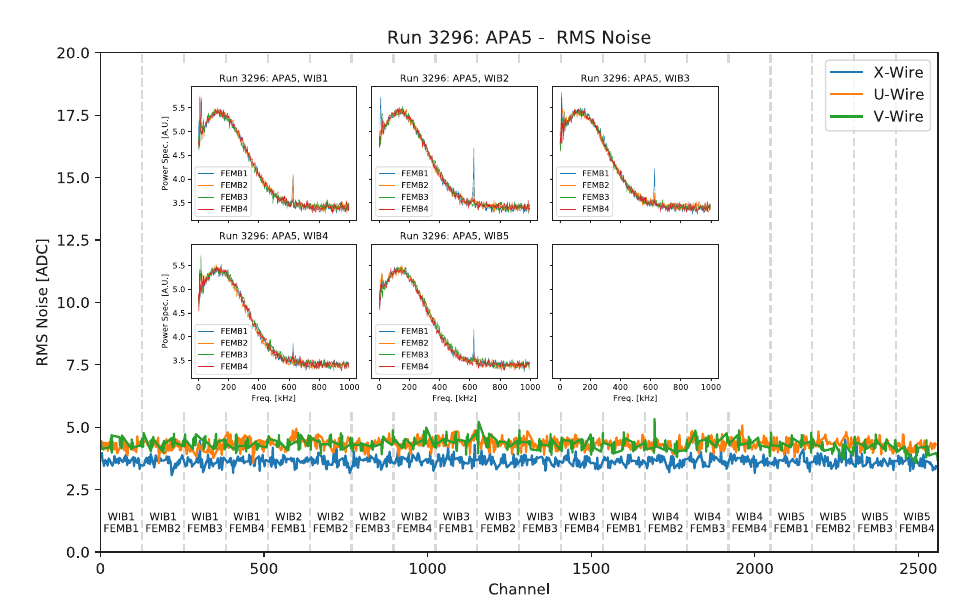
Figure 4. An example of TPC wire noise measurement of an APA. The source of excessive noise at 600 kHz was identified due to the camera